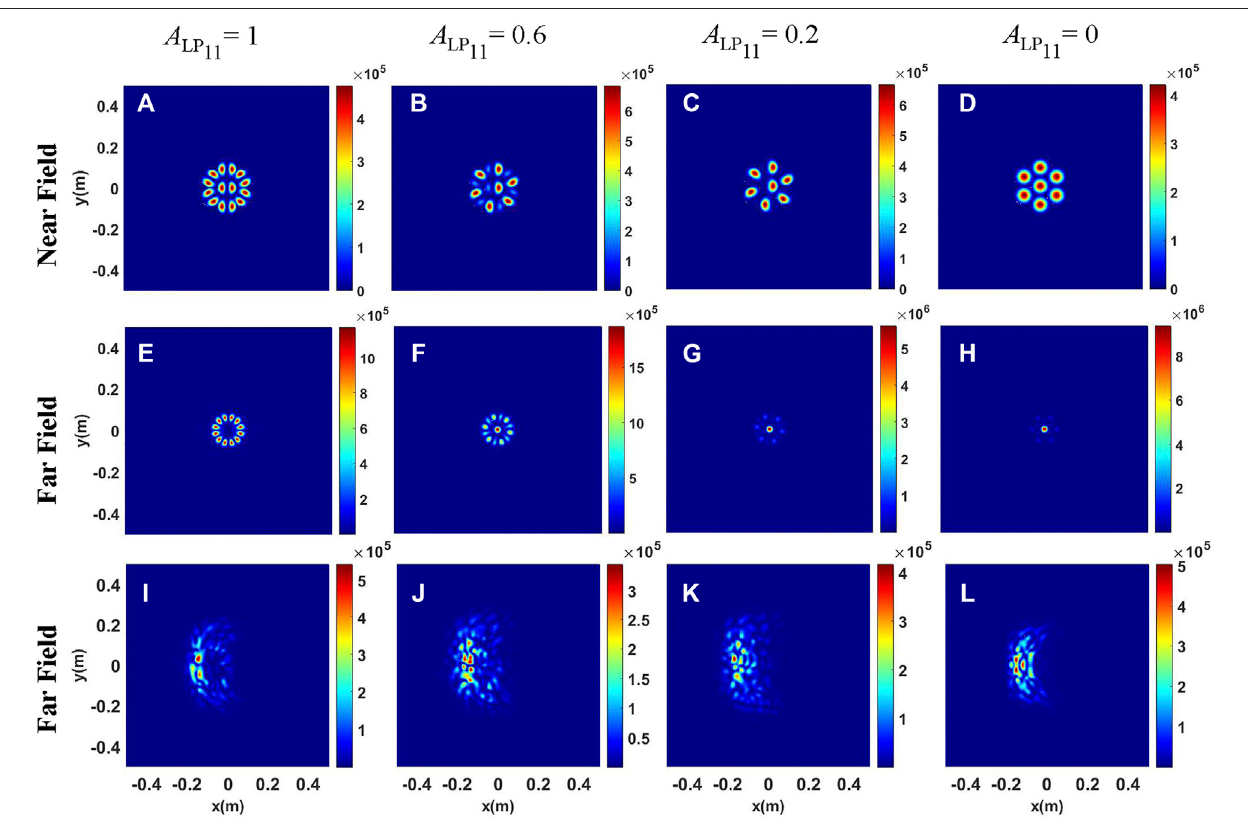
FIGURE 9 | Intensity distributions of the mixed-mode beam array for different content of the LP 01 mode. (A – D) Intensity distributions at the initial plane; (E – H) Intensity distributions at the receiver plane in free space; (I – L) Intensity distributions at the receiver plane under the conditions of thermal blooming.